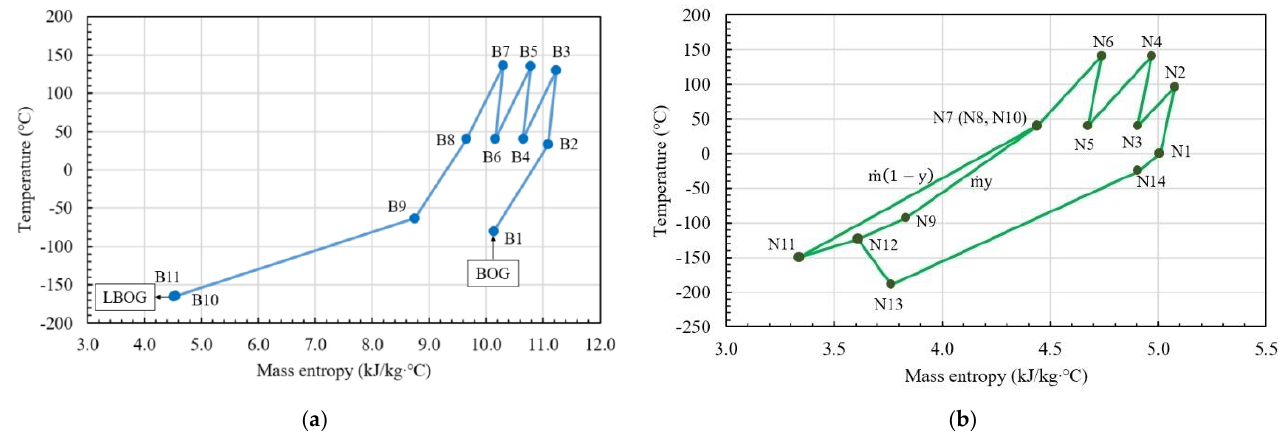
Figure 10. T-S diagram of the BOG re-liquefaction system for Case 2: ( a ) BOG, ( b ) N 2 .